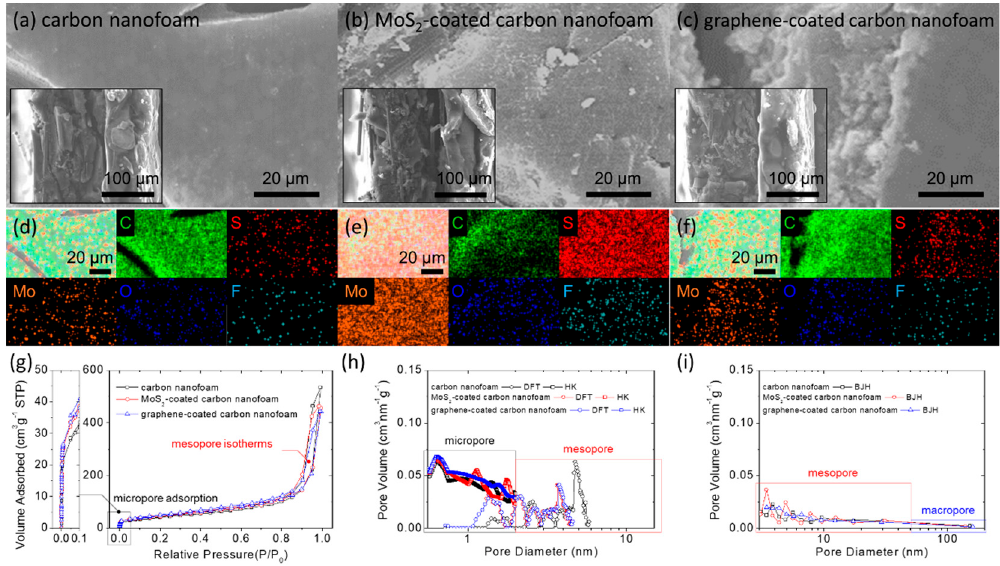
Figure 1. Material characterization: microstructural inspection of the ( a ) carbon nanofoam, ( b ) MoS 2 -coated carbon nanofoam, and ( c ) graphene-coated carbon nanofoam by field-emission scanning electron microscopy (insets are the cross-sectional inspection); elemental mapping results of the ( d ) carbon nanofoam, ( e ) MoS 2 -coated carbon nanofoam, and ( f ) graphene-coated carbon nanofoam by energy-dispersive X-ray spectroscopy; porosity analysis with ( g ) nitrogen adsorption/desorption isotherms, ( h ) pore size distribution calculated with density functional theory (DFT) and Horvath–Kawazoe (HK) theory, and ( i ) Barrett-Joyner-Halenda (BJH) pore size distribution. Table 1. Chemical composition of carbon nanofoams.